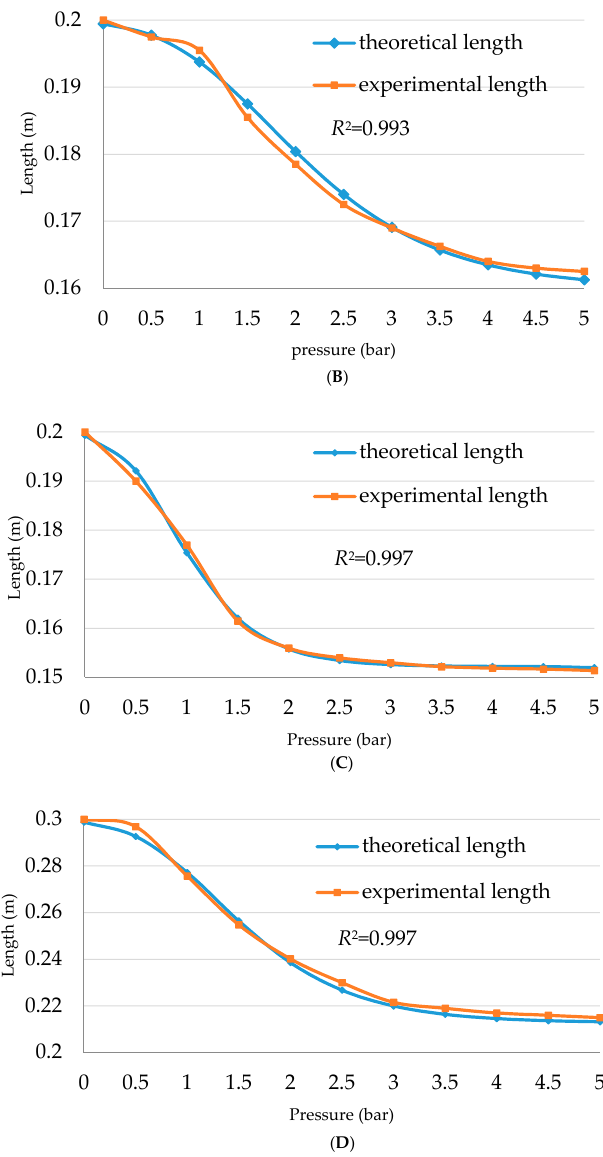
Figure 12. The experimental and theoretical length of the PMAs. ( A – D ) represent the length for the PMAs in Table 5 respectively.